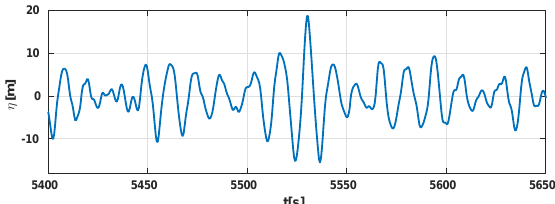
Figure 19. Case TS10000. Zoomed version of the freak wave; the crest height is 1.22m and the wave height is 2.23 times the signifi- cant wave